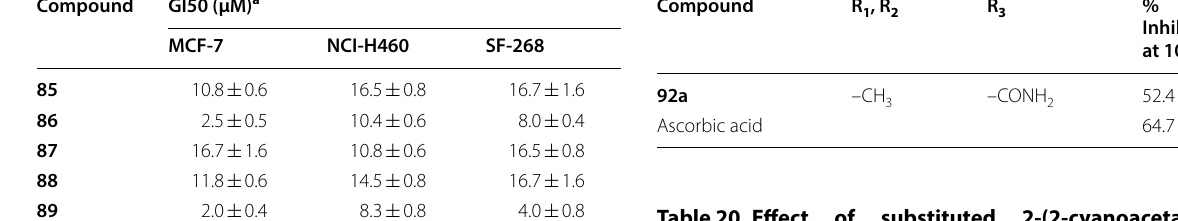
of the synthesized compounds Compound